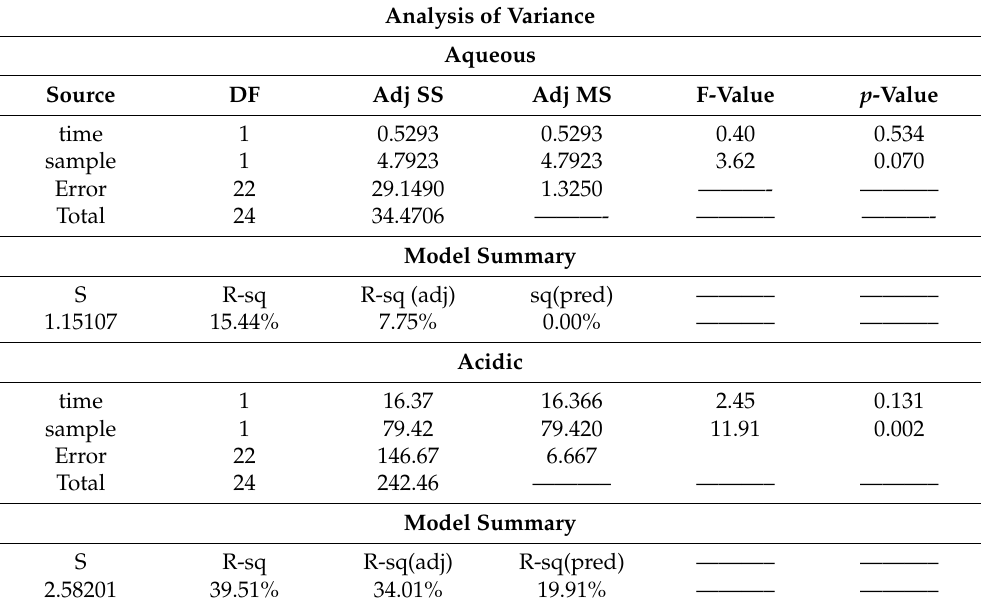
Table 1. Statistical analysis of variance (Two-way Anova) for the optimization of aqueous and acidic